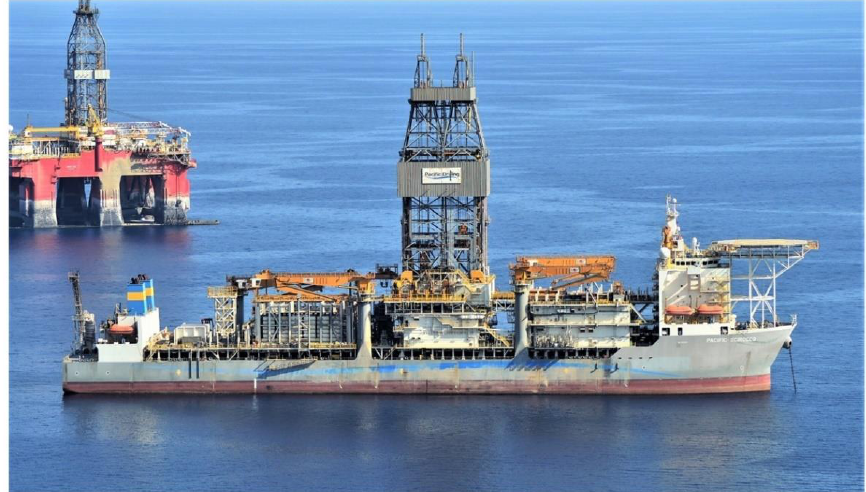
Figure 5. Drillships near a semi-submersible drilling rig.